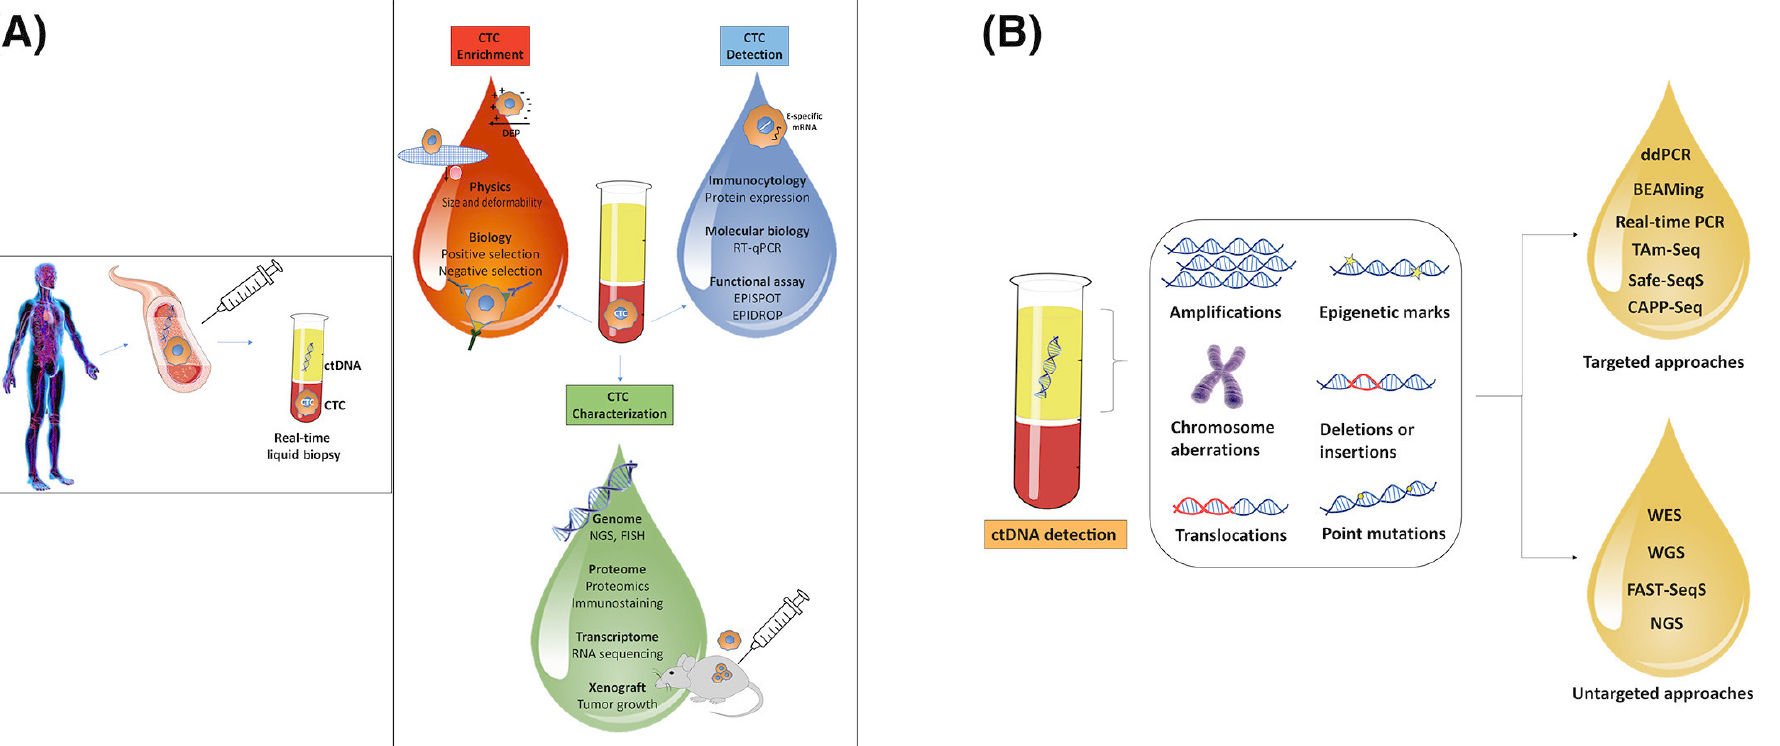
Figure 1. ( A ) Schematic representation of enrichment, detection and characterization of circulating tumor cells (CTCs). ( B ) ctDNA detection technologies. ctDNA analysis is based on the identification of tumors’ specific aberrations or epigenetic marks in cfDNA samples. Targeted approaches allow pre-specified cancer- associated mutations, whereas untargeted approaches facilitate detection of genomic aberrations without requiring prespecified information about the mutation pattern of the primary tumors. (Reprinted with permission from Heidrich et al. [30], Copyright 2020 International Journal of Cancer, open access article published under Creative Commons Attribution license (CC BY 4.0).